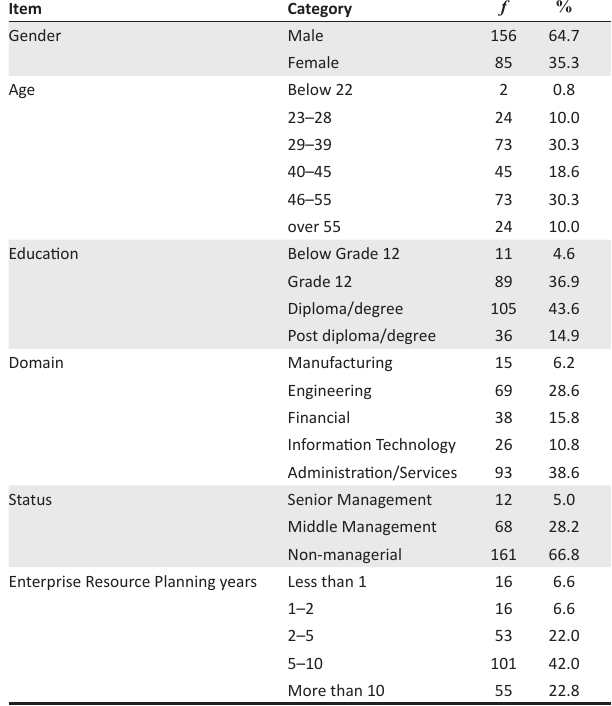
TABLE 2: Characteristics of participants ( N =